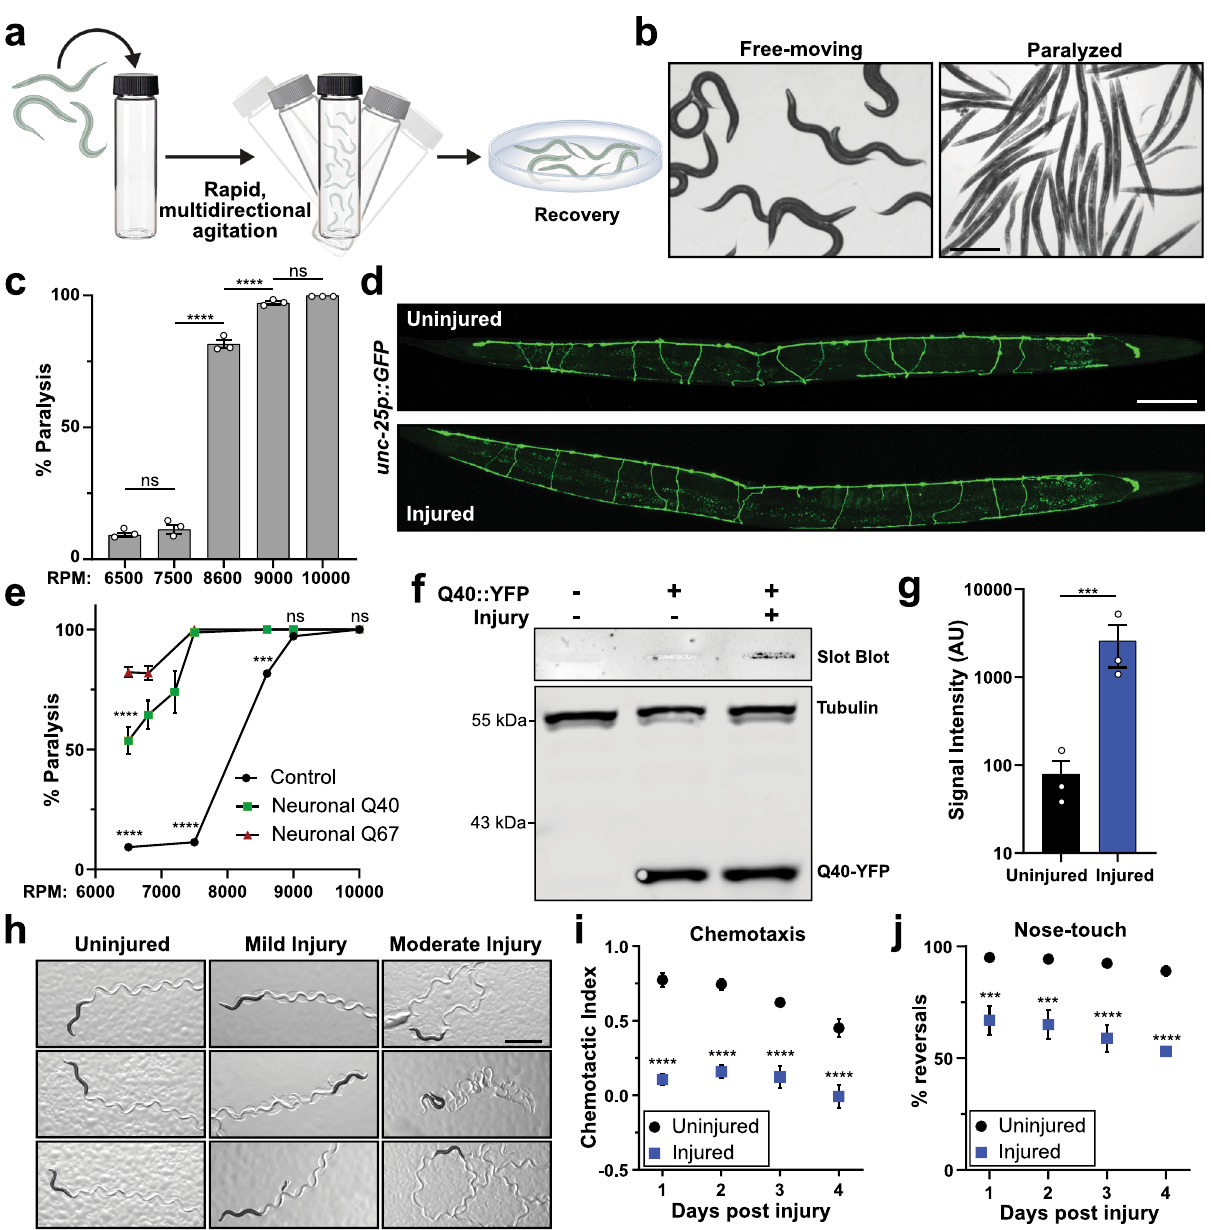
Fig. 1 Blunt force trauma induces neuronal dysfunction in C. elegans . a Diagram depicting method of delivering blunt trauma to worms. b Micrographs of worms exhibiting movement with normal body bend (left) versus post injury paralysis (right). Reference Fig. 1c. Scale = 400 µ m. c Percent of animals entering paralytic state immediately post injury is dependent on agitation frequency. Mean ± SEM, ns (not signi fi cant) p = 0.7044 and 0.4494, **** p < 0.0001 by two-way ANOVA with Tukey multiple comparison test. n = 3 independent trials. d Fluorescence maximum projections of Z-stacks taken by confocal microscopy of worms expressing GFP in GABAergic neurons. Worms imaged either uninjured or 1 h post injury. Reference Supplementary Fig. 1b. Scale = 100 µ m. e Paralytic response to injury in either a control worm strain (from Fig. 1c, black circles), or worms expressing polyglutamine expansions Q40::YFP (soluble, green squares) or Q67::YFP (insoluble, red triangles) in neurons. Mean ± SEM, **** p < 0.0001, *** p = 0.0001 by two- way ANOVA with Tukey test, n = 3 independent trials. f Filter trap analysis of SDS-resistant aggregates on cellulose acetate membranes from neuronally expressed Q40::YFP worms either uninjured or 48 h post injury. Western blots for the respective proteins resolved by SDS-PAGE in the bottom panel. g Quanti fi cation of fi lter trap. Shown are log-transformed values of slot blot band intensity with black and blue denoting uninjured and injured worms, respectively (corrected for loading by YFP signal). Mean ± SEM, ** p = 0.0008 by two-sided ratio-paired t -test, n = 3 biological replicates. h Micrographs of worm tracts on E. coli lawn to assess movement 48 h after receiving no injury, non-paralytic mild injury (7500 rpm), or paralytic moderate injury (8600 rpm). Scale = 1 mm. i Chemotaxis of uninjured (black circles) or injured worms (blue squares) with butanol 24 – 96 h post injury. Chemotactic index of 1.0 indicates 100% preference for butanol and 0.0 indicates no preference. Mean ± SEM, **** p < 0.0001 and uninjured Day 1 vs Day 4 *** p = 0.0005 by two-way ANOVA with Tukey test, n = 6 independent trials for day 1, 2, 4 and n = 3 independent trials for day 3. j Gentle nose touch assay of uninjured (black circles) or injured worms (blue squares), in which a stop and reversal of worm movement indicated a positive response. Mean ± SEM, *** p = 0.0006 and 0.0004, **** p < 0.0001 when compared to uninjured by two-way ANOVA with Tukey test, n = 200 animals per condition over three independent trials.